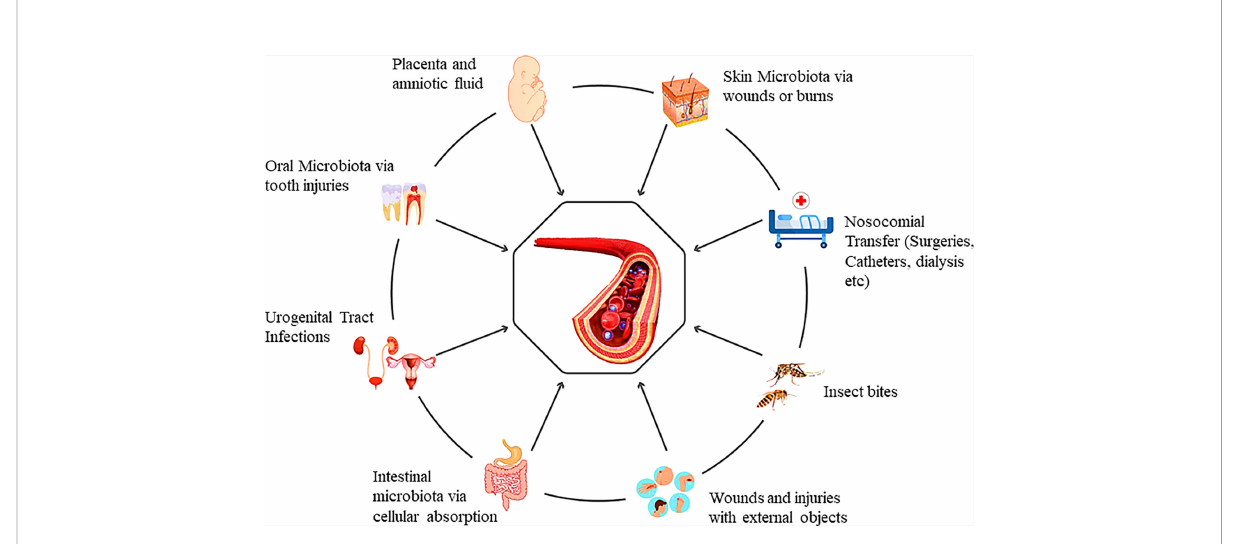
FIGURE 1 Genesis of the blood microbiota and the multiple possible entry